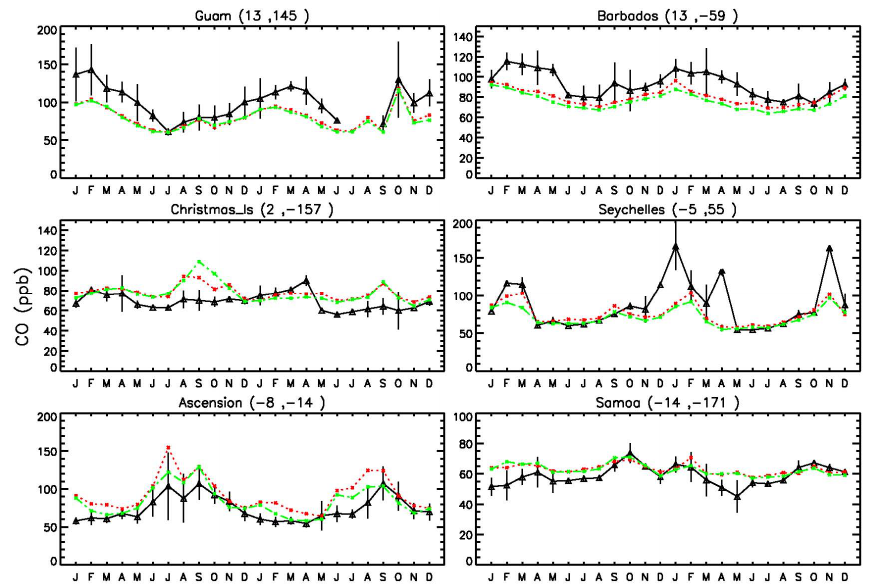
Fig. 2. Monthly variation of CO (ppb) from January 2005 to December 2006 at six tropical surface sites. Observations from the NOAA/GMD are in black (Novelli et al., 2003), GEOS-Chem model simulations are shown in red (GEOS-5) and in green